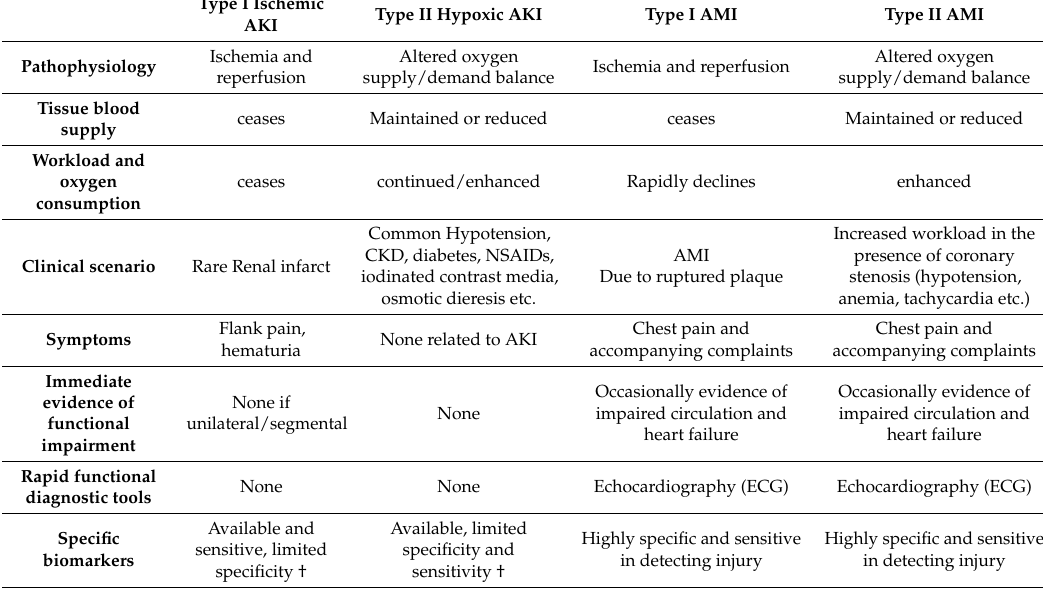
Table 1. Types of acute kidney injury (AKI) and acute myocardial infarction (AMI)-similarities and